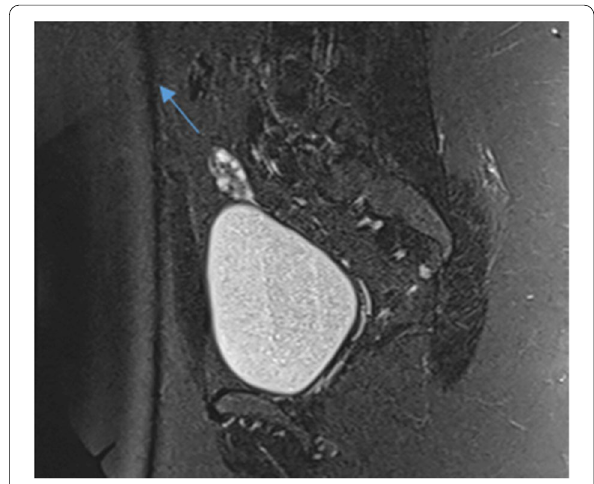
Fig. 4 Sagittal T2 STIR showed polycystic appearance of ovary (base of blue arrow)